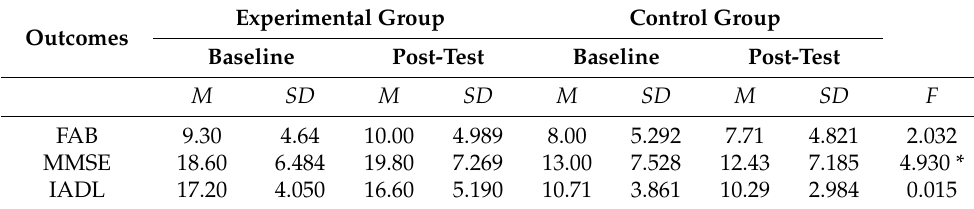
Table 3. Pre-post-comparisons for the parametric